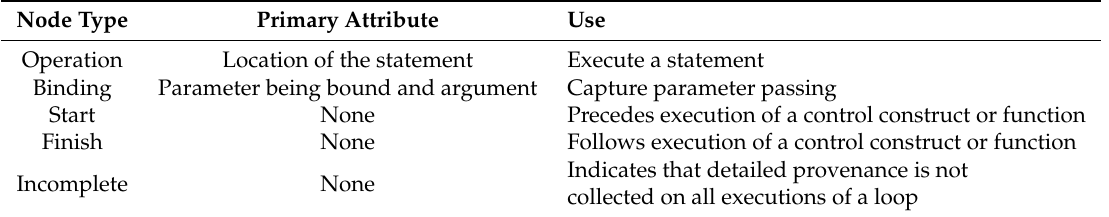
Table 2. Procedural node types.